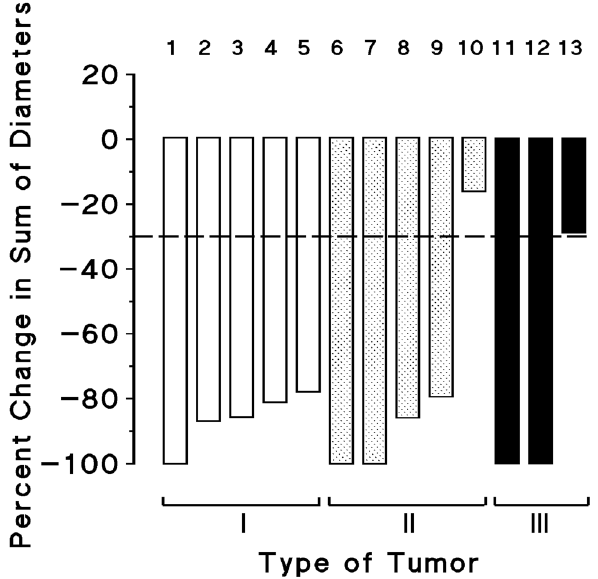
Figure 2. Clinical antitumor response in 13 patients treated with regimens comprising 5-fluorouracil, folinic acid, and high-dose pyridoxine in tandem. Types of tumor included colorectal adenocarcinoma (I), pancreas adenocarcinoma (II), and squamous cell carcinoma of the esophagus (III). Clinical assessment comprised CT scan, MRI, and/or endoscopic ultrasonography (EUS) imaging when required. In patients who had